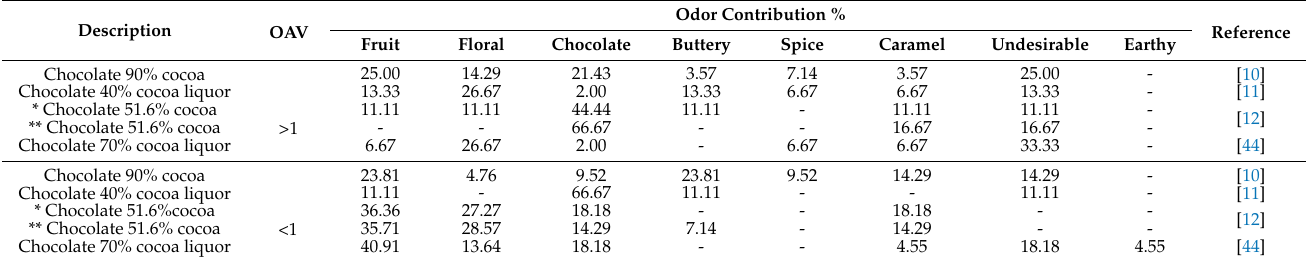
Table 6. Odor activity values of key aroma compounds in dark